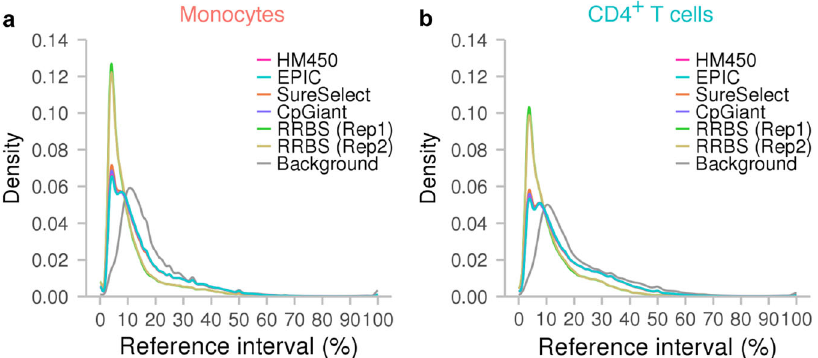
Fig. 9 DNAm variability for target CpG sites. a Distributions of reference intervals in monocytes. b Distributions of reference intervals in CD4 + T cells. CpGiant SeqCap Epi CpGiant, HM450 HumanMethylation450, Rep replication, RRBS reduced-representation bisul fi te